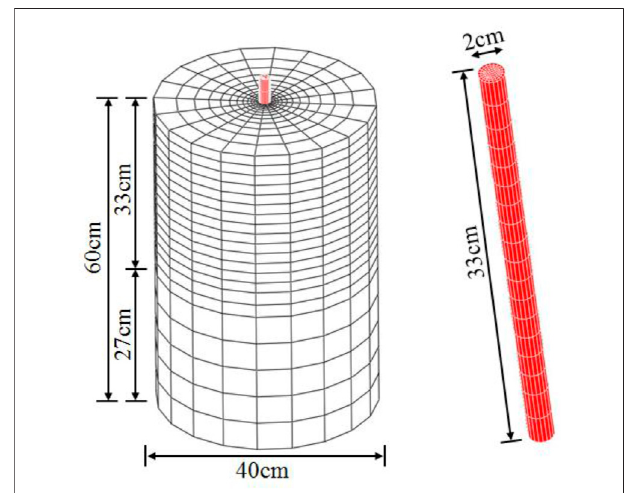
FIGURE 6 | Three-dimensional fi nite element